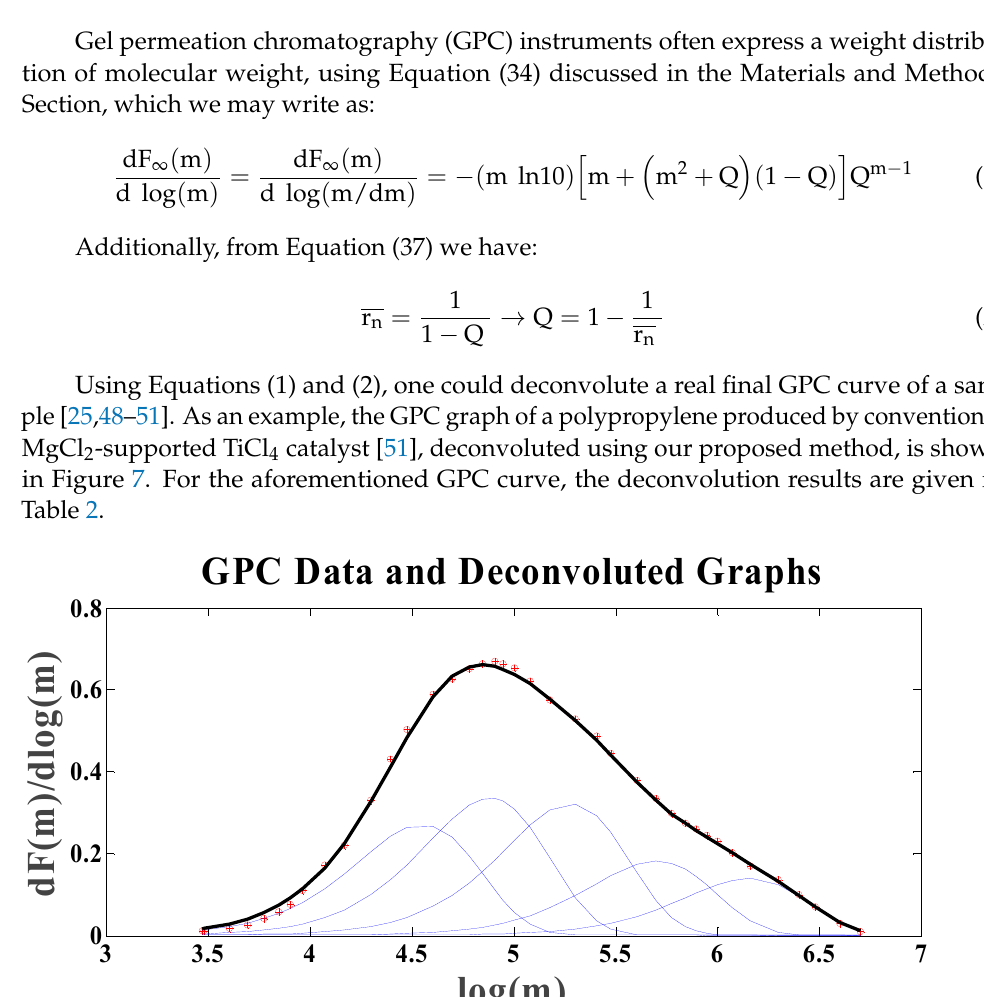
Figure 7. Deconvoluted GPC curve of a typically produced polypropylene.